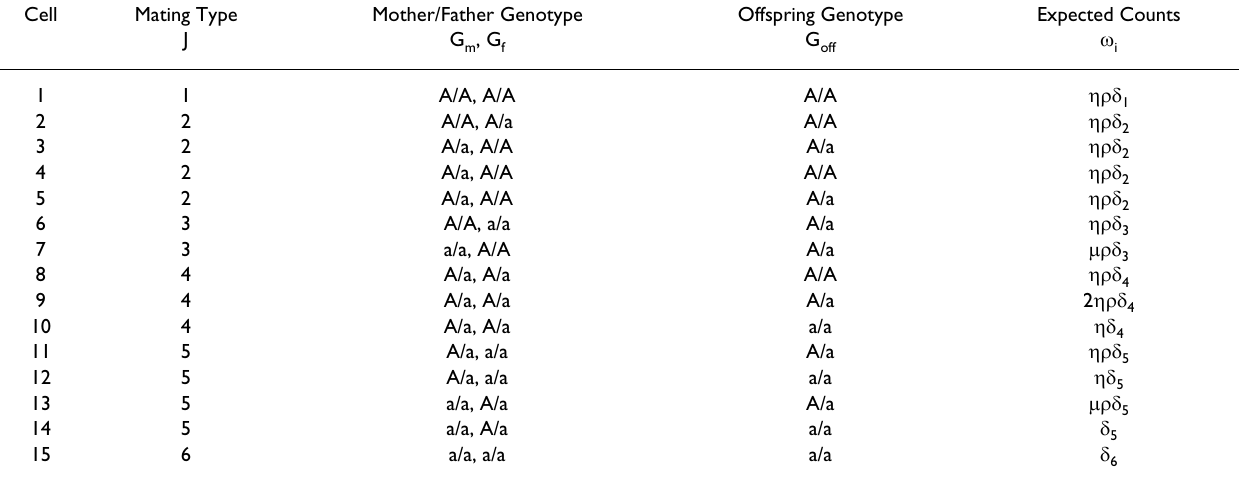
Table 4: Case parent/offspring triads and expected triad counts for analysis model 3 using the log-linear regression Cell Mating Type Mother/Father